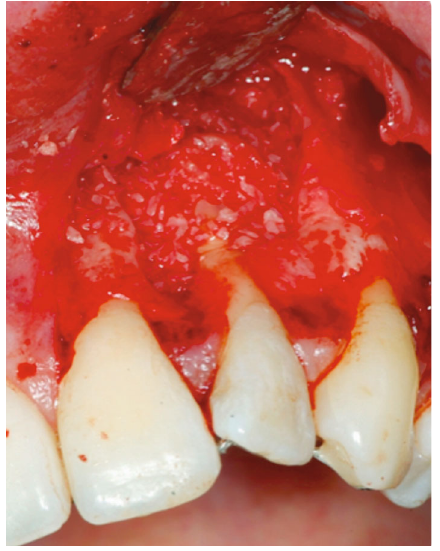
Figure 9: Membrane positioned.